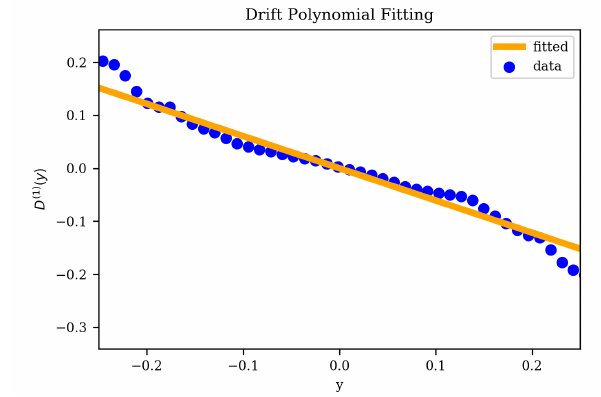
Figure 5. Drift parameter fitted to a first-order polynomial.